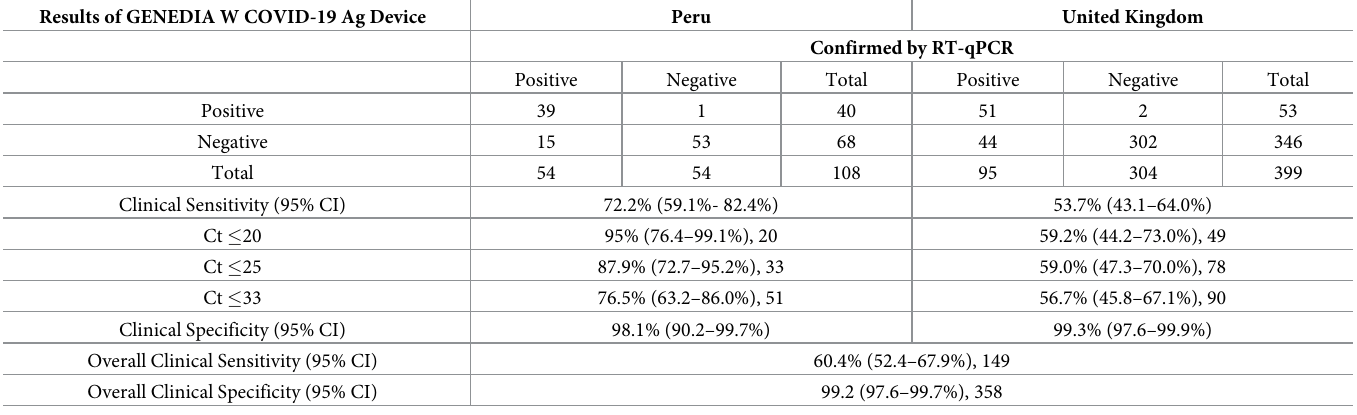
Table 2. Results and clinical sensitivity and specificity of the GENEDIA W COVID-19 Ag Device based on COVID-19 RT-qPCR result in the UK and Peru. Results of GENEDIA W COVID-19 Ag